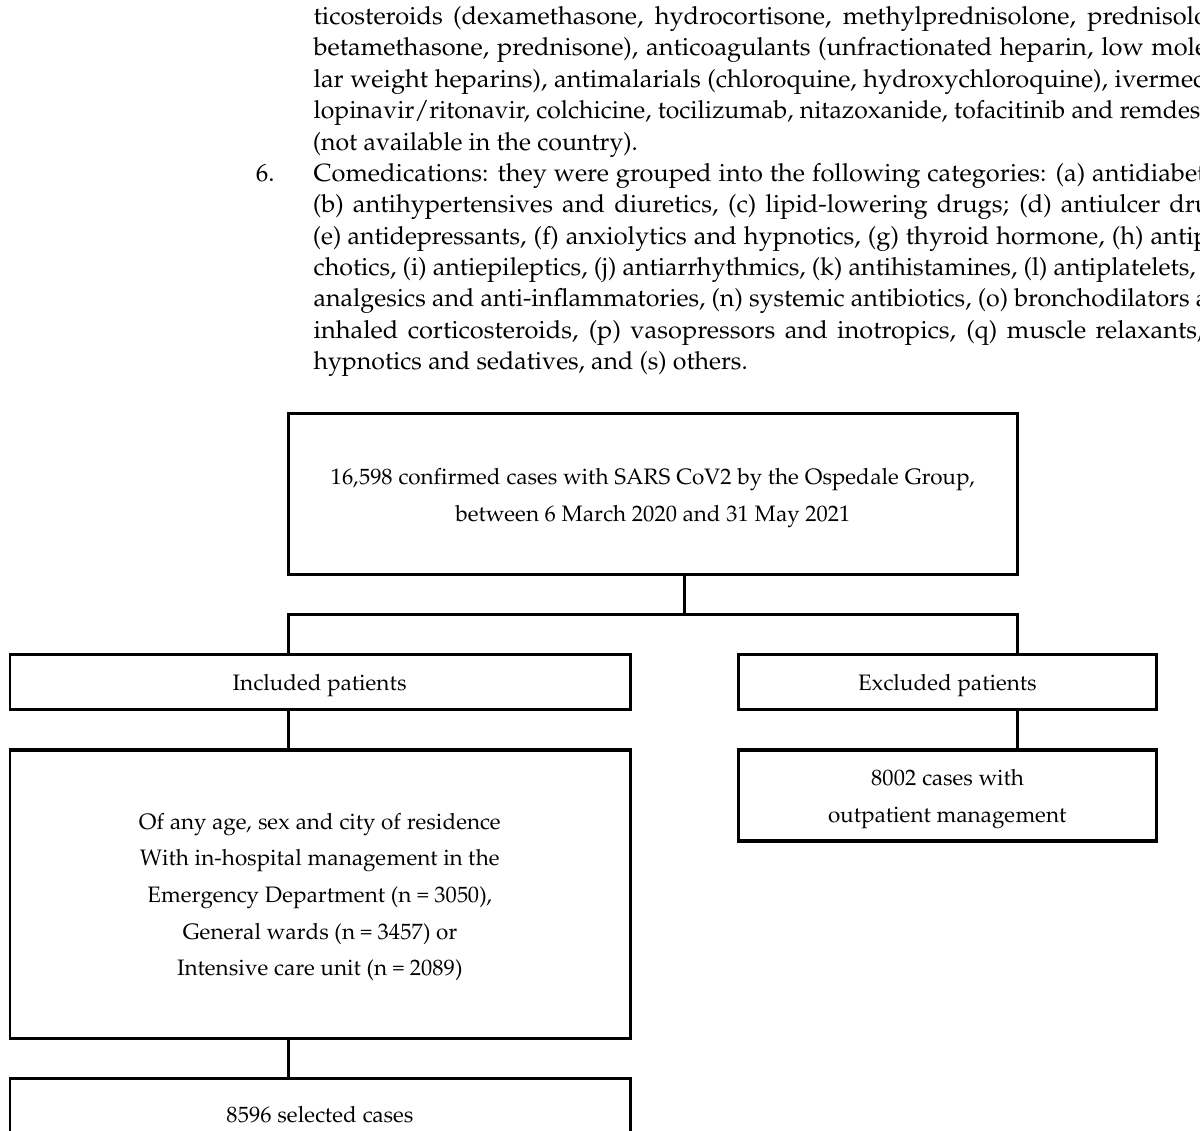
Figure 1. Flowchart with the determination of patients who were included with pharmacological treatment for Covid-19 in different regions of Colombia.